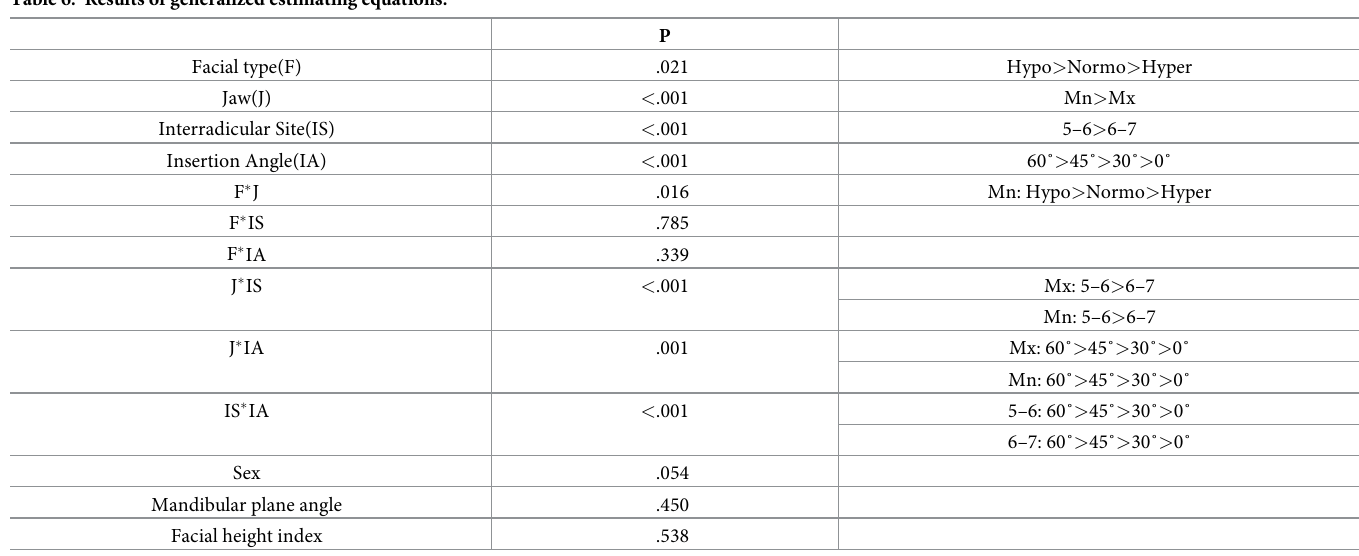
Table 6. Results of generalized estimating